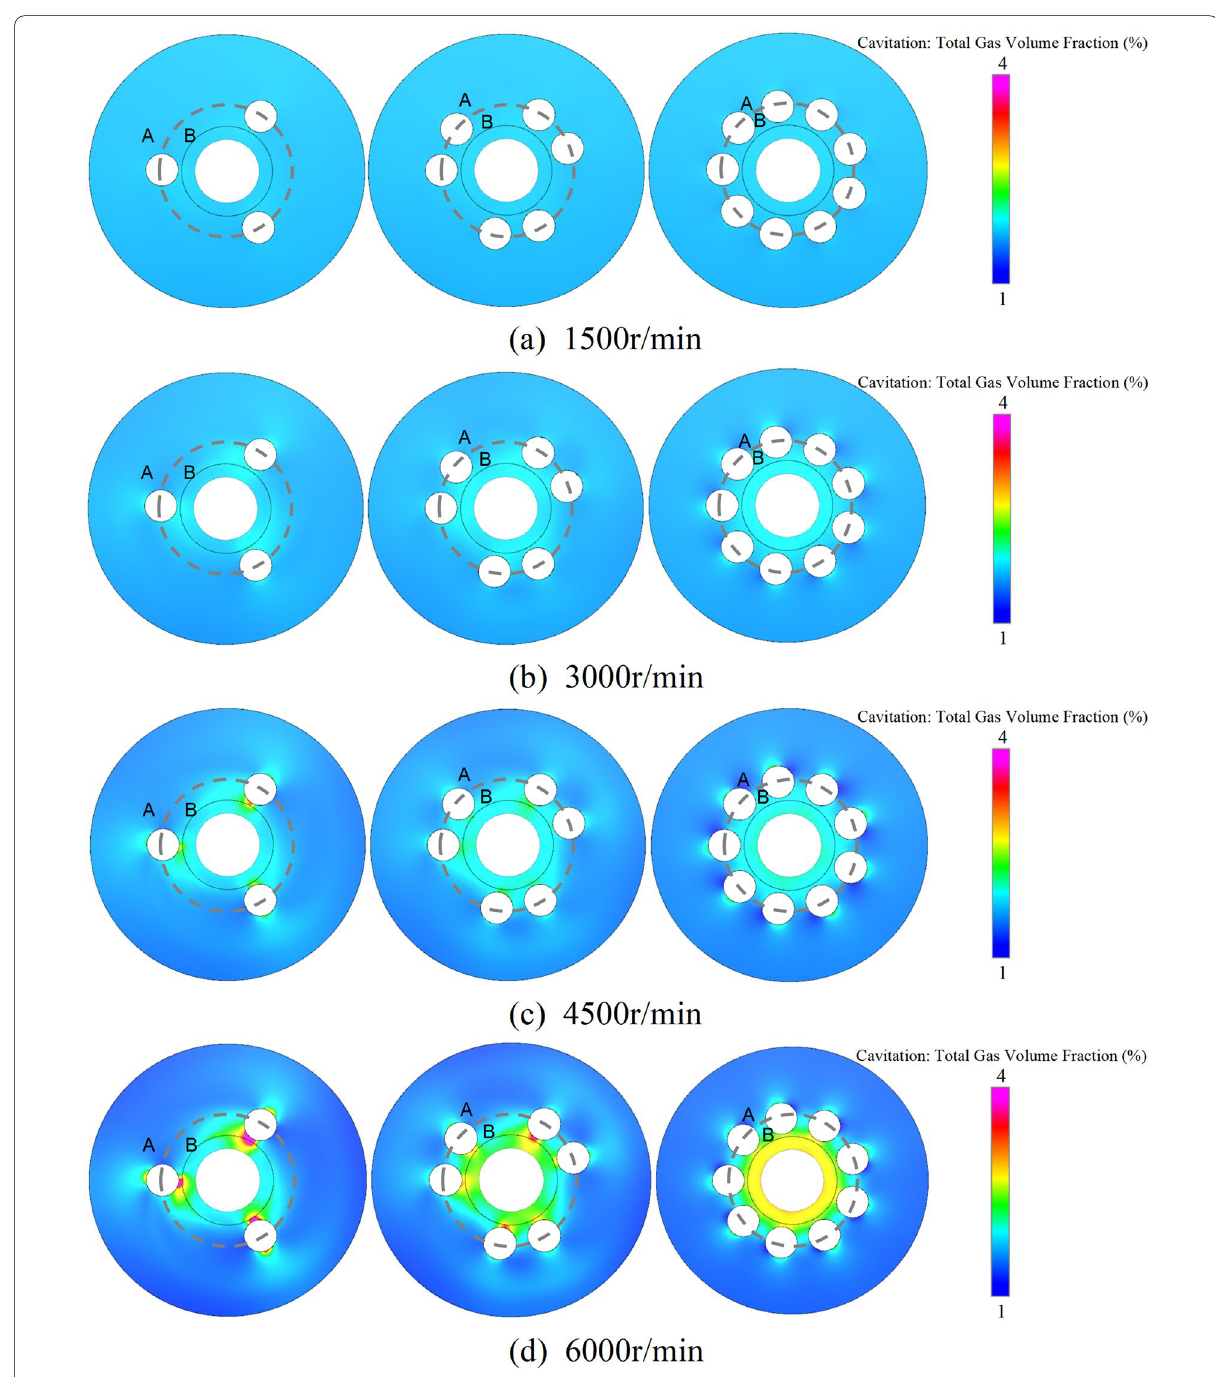
Figure 8 Cavitation cloud diagram of the fluid